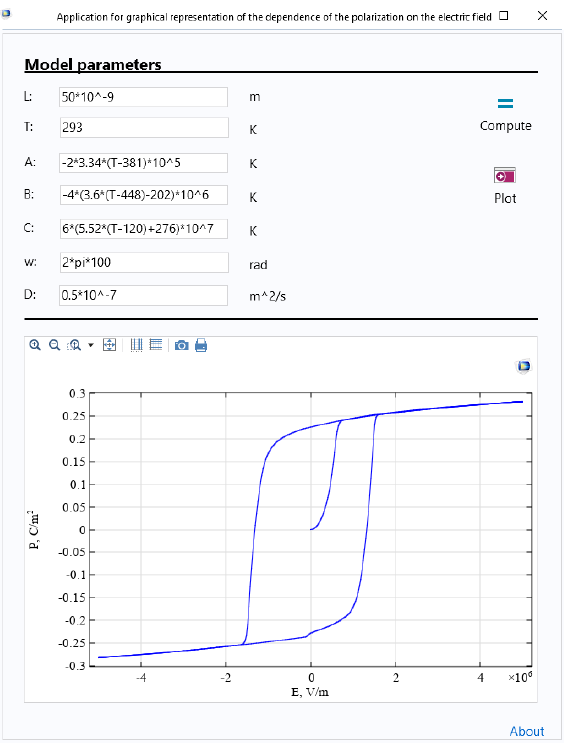
Figure 6. The general view of the user interface application for graphical representation of polari- zation–electric field dependencies. polarization–electric field